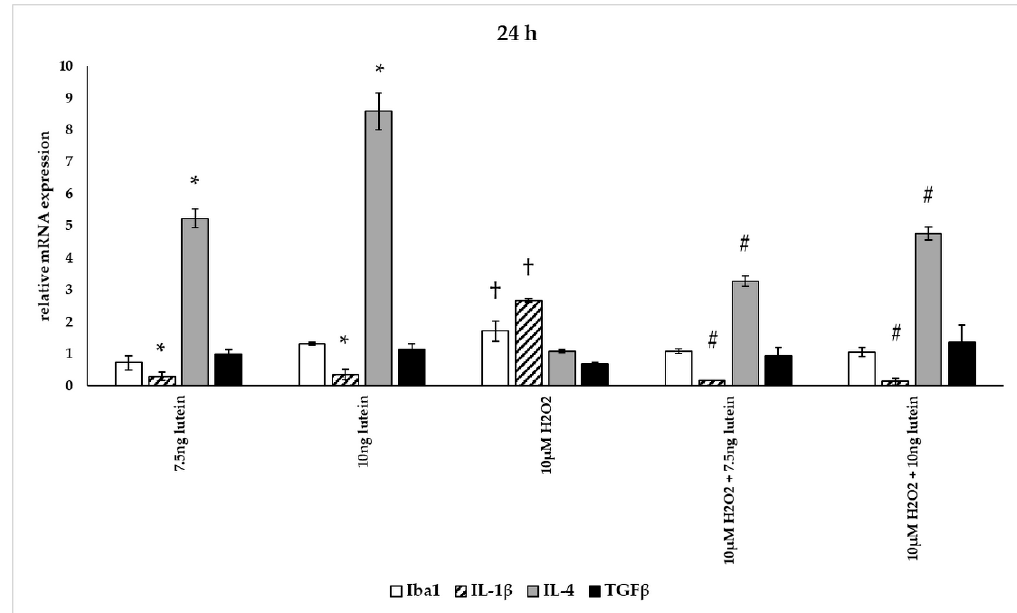
Figure 13. Effects of lutein and H 2 O 2 on Iba1, IL-1 β , IL-4 and TGF β mRNA expression at 24 h. The columns represent the mean values, and error bars indicate the standard deviation (SD) of three independent experiments ( n = 3), each performed in triplicate, and are presented relative to own control cells. * indicates statistical significance of lutein treatments versus controls; † indicates statistical significance of H 2 O 2 treated cells compared to controls; # indicates statistical significance of combined (lutein with H 2 O 2 ) treatments compared to H 2 O 2 treatments; the level of significance was p < 0.05. Real-time PCR was performed with the SYBR green protocol using gene-specific primers. β -actin was used as house-keeping gene for the normalization. The relative expression of controls was regarded as 1.